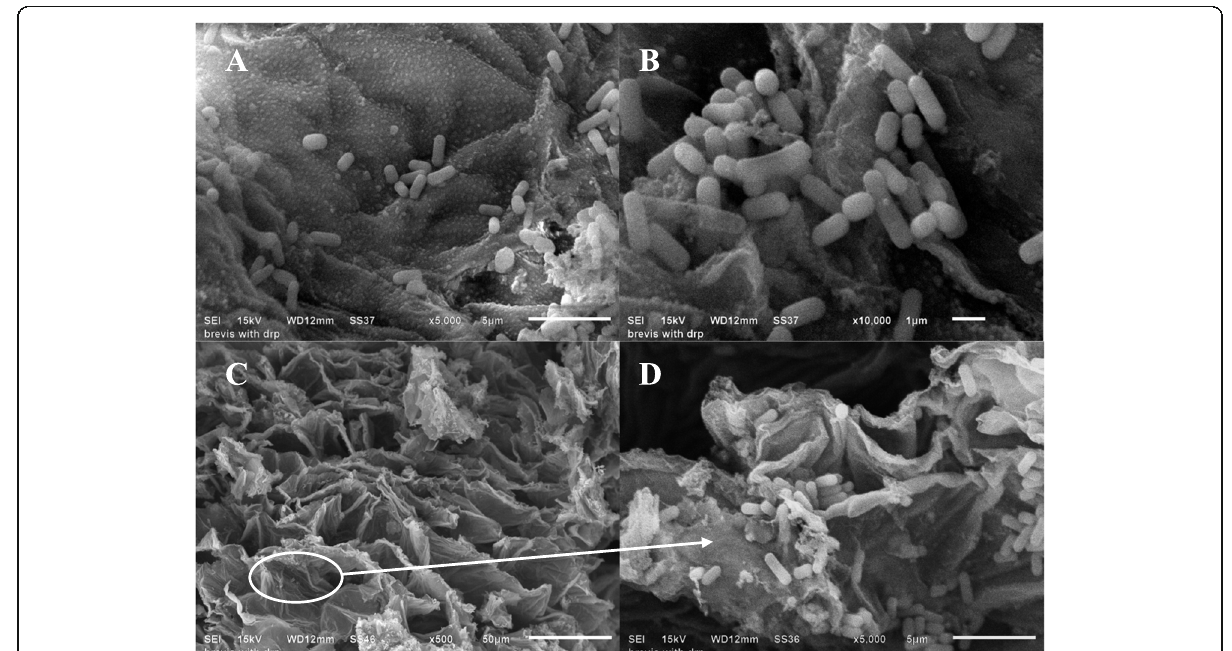
Fig. 4 Scanning electron micrographs of cross-sections of DRP loaded with L.